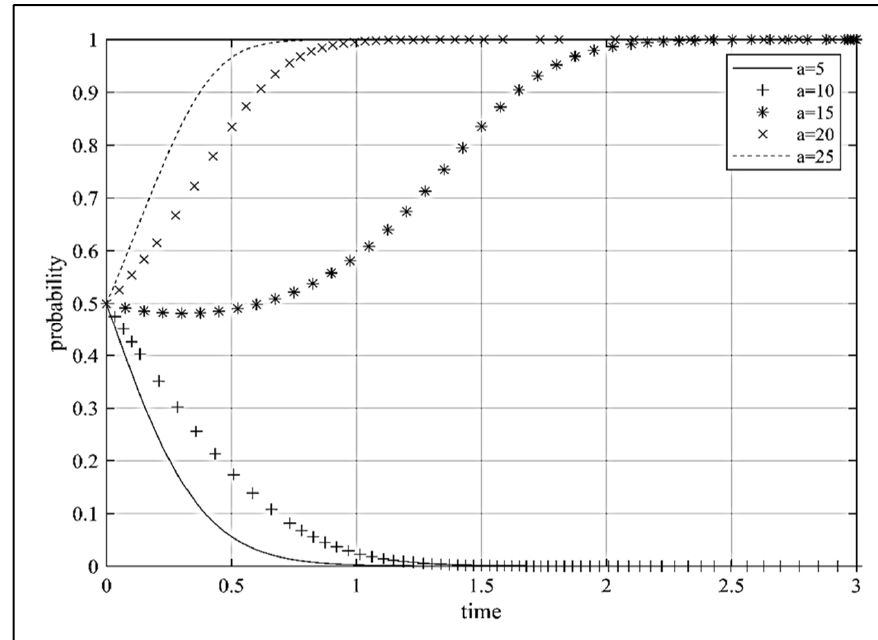
Figure 5. Evolution path of global warming with different parameter values.